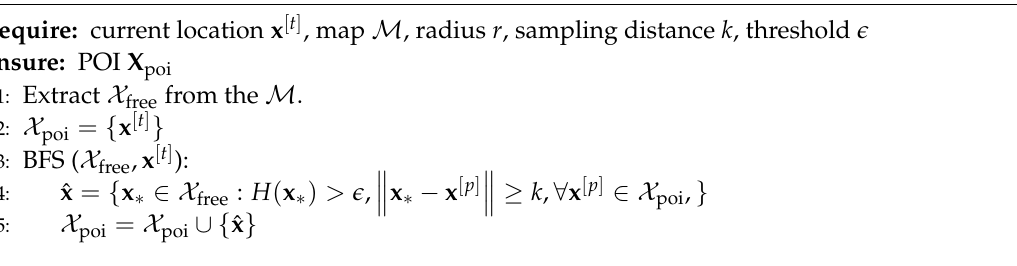
Algorithm 1 informative candidates X poi